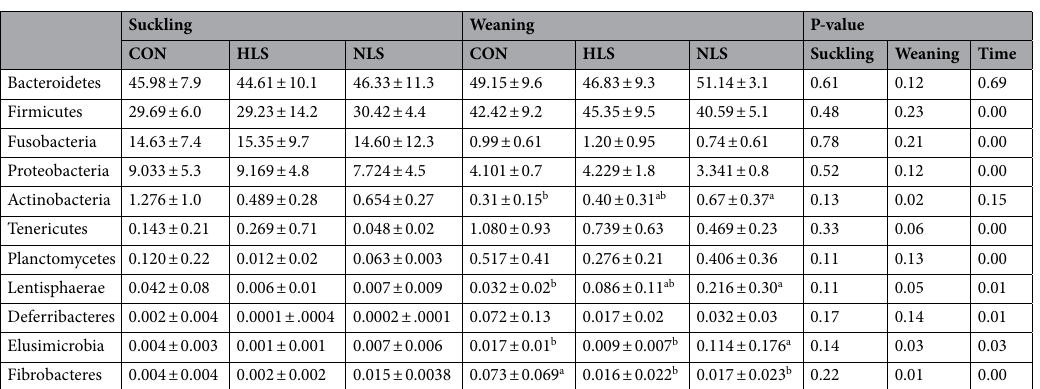
Table 1. Relative abundance of the fecal microbiota phyla of three groups at suckling (d 4) and weaning (d 21) periods. CON, Control; HLS, Lactobacilus salivarius 144 isolated from fast-growing pig feces; NLS, L. salivarius 160 isolated from normal weight pig feces. a-b Means with different superscripts within rows are significantly different at P < 0.05.